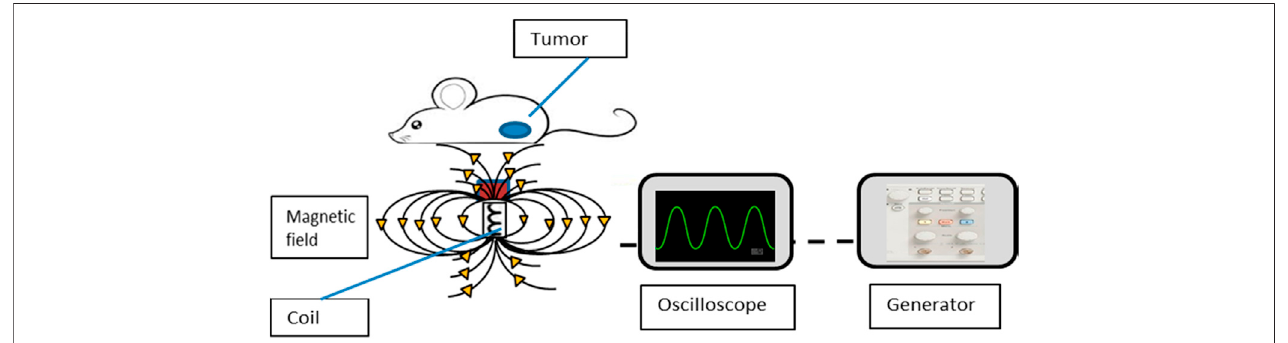
FIGURE3| Adepictionofhowthemagnetic fi eldisgeneratedfromthecoiltoaffecttumorcells.Ageneratorisconnectedtoacoilandoscilloscope.Thegenerator provides voltage and frequency to the coil while the oscilloscope displays the frequency and amplitude on a screen. Reproduced from Vegerhof et al. (2016)